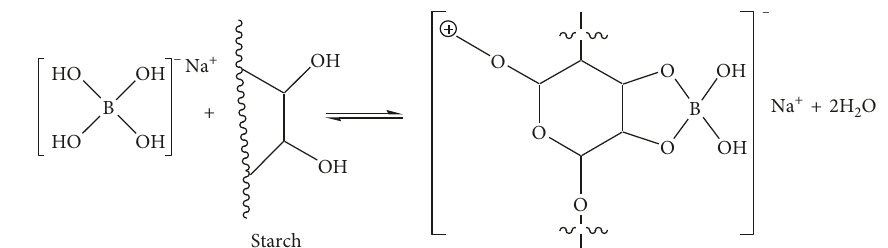
Scheme 8: Starch molecules crosslinked with borax.